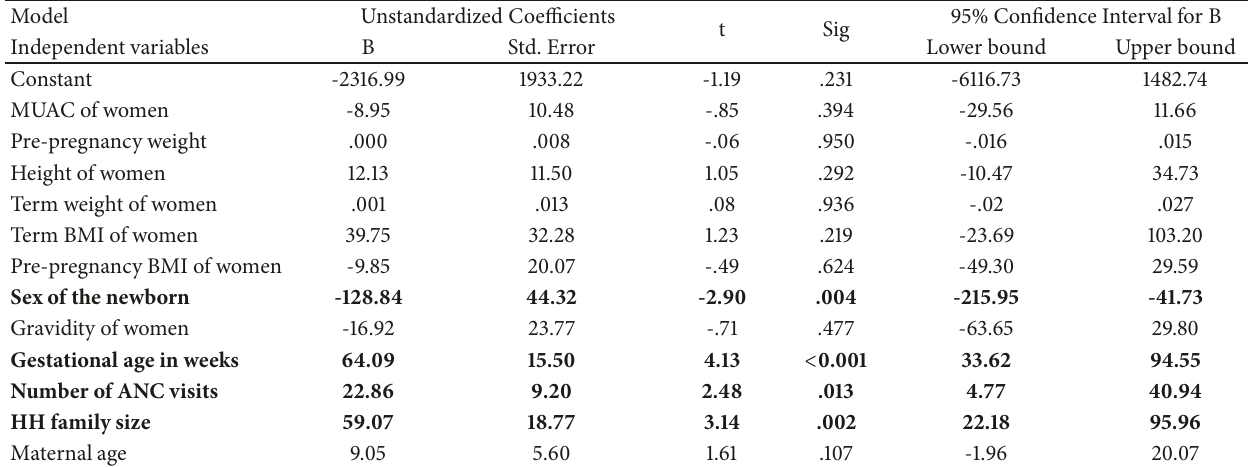
Table 3: Multivariate linear regression showing the association between dependent variables and dependent